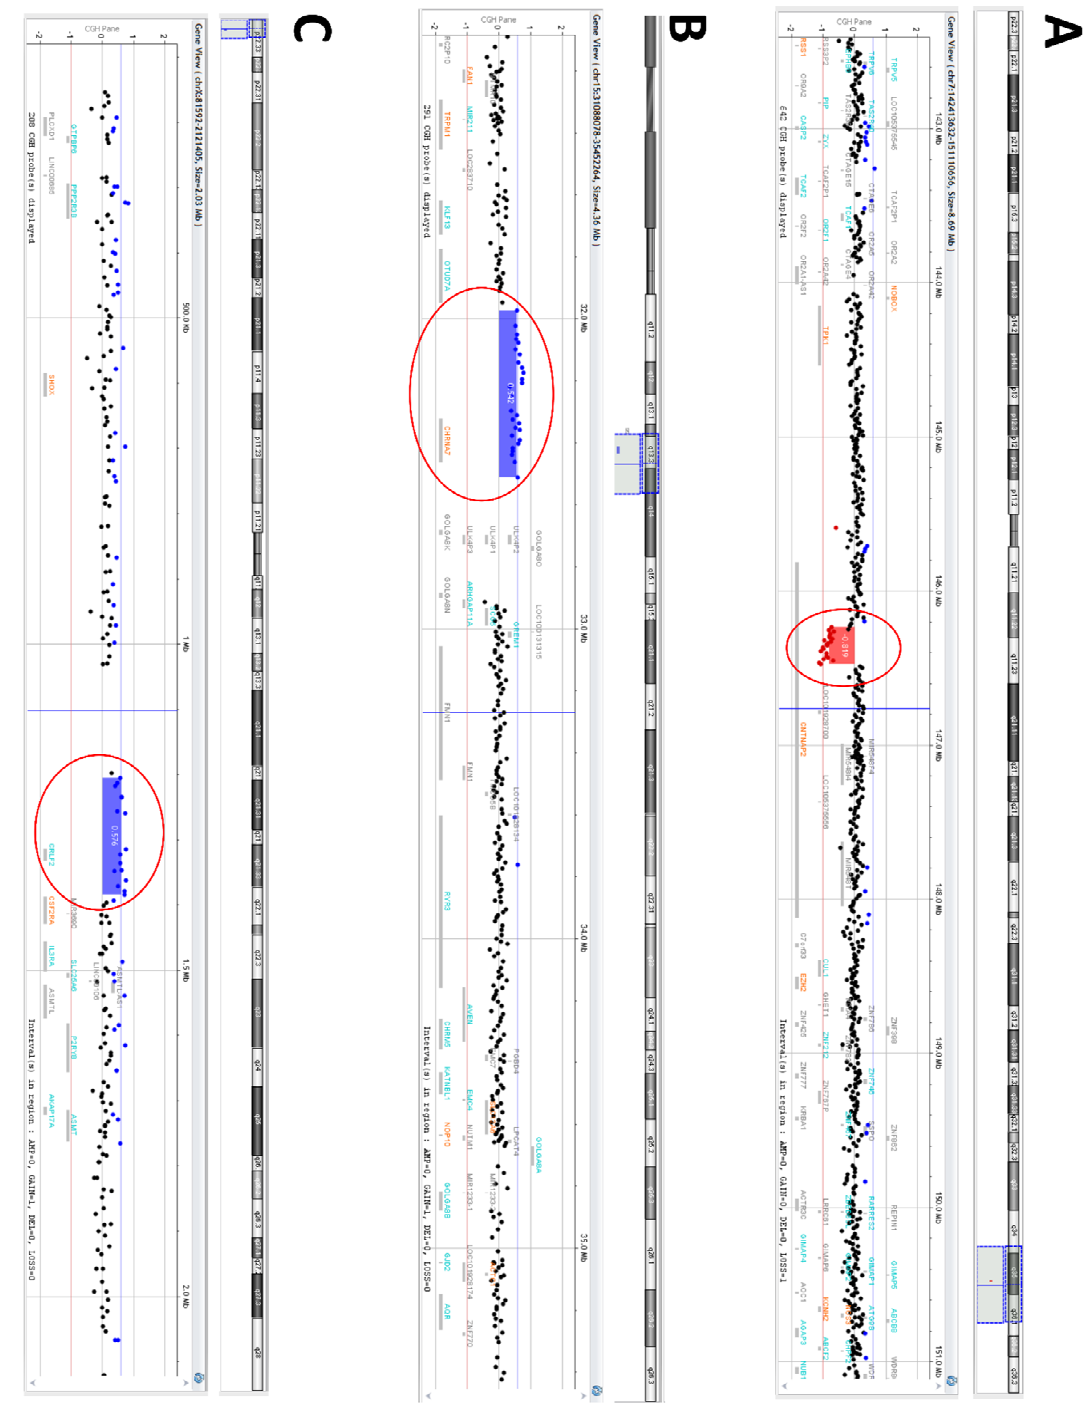
Figure 2. Oligoarray profile of our patient showing three different CNVs: ( A ) 7q35 microdeletion (red bar), involving the exon 2 of CNTNAP2 gene (NM_014141.6; ENST00000361727.3), ( B ) 15q13.3 microduplication (blue bar), including the entire CHRNA7 gene, and ( C ) pseudoautosomal region Xp22.33 microduplication (blue bar), encompassing the entire CRLF2 gene.